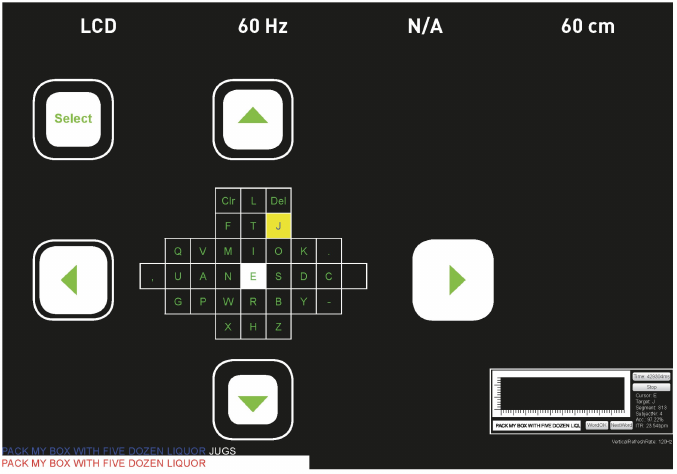
Figure 11. A similar GUI to the Bremen-BCI Speller during the selection of the right arrow, as the box size is increasing during selection [106]. Figure modified from [106].